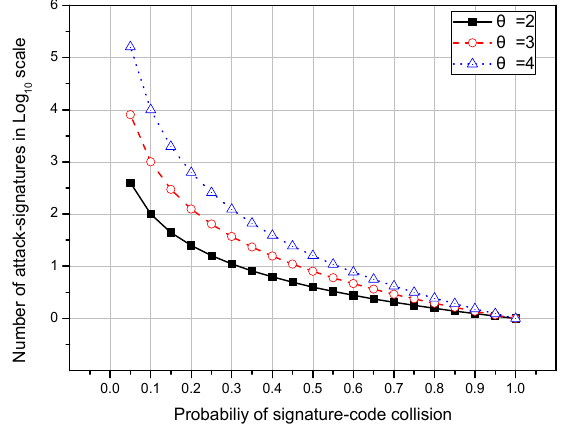
Figure 8. Number of signatures that can be added without experiencing a